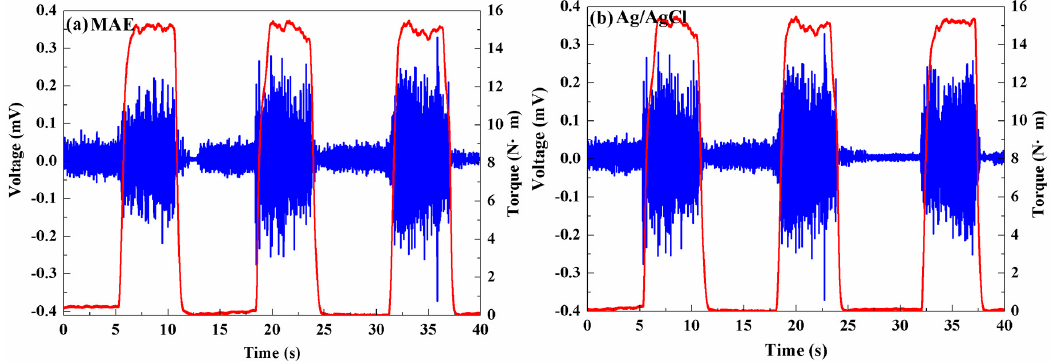
Figure 9. EMG signals recorded by: ( a ) MAE; and ( b ) Ag/AgCl electrodes.